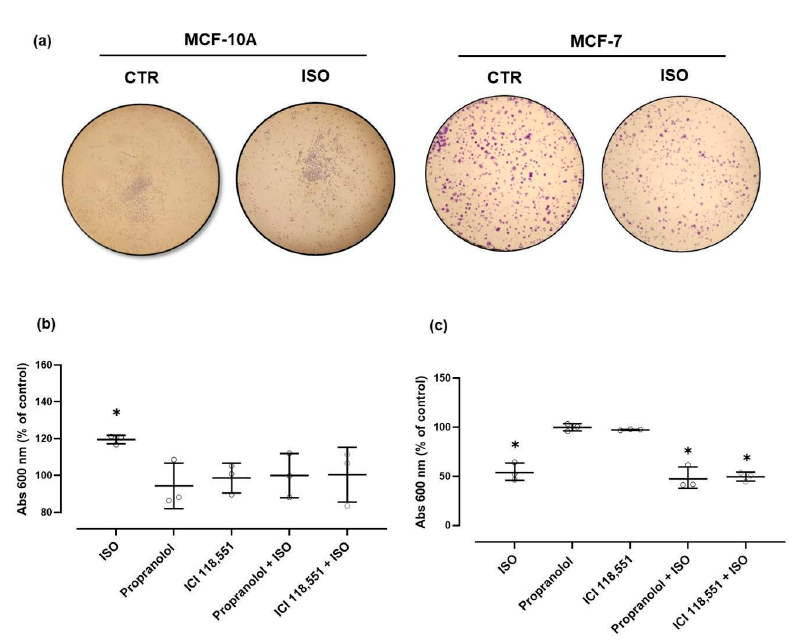
Figure 4. Influence of β -adrenoceptor agonist, 10 µM isoprenaline (ISO), alone or in combination with β -adrenoceptor antagonists, propranolol or ICI 118,551 (1 µM), in MCF-10A and in MCF-7 cells clonogenic ability. Cells were treated with the indicated drugs for seven days. ( a ) Representative images of the colony formation assay in MCF-10A and in MCF-7 cells in the absence or in the presence of isoprenaline (10 µM). ( b ) Results for absorbance ( λ = 600 nm: Abs 600 nm), after crystal violet elution in MCF-10A cells. ( c ) Results for absorbance ( λ = 600 nm: Abs 600 nm), after crystal violet elution in MCF-7 cells. Results are expressed as a percentage of control (solvent) and are presented as mean ± SD, from 3 independent experiments. Significant differences from control group: * p ≤ 0.05; one-way analysis of variance (ANOVA), followed by post-hoc multi-comparisons Dunnett’s test. In MCF-7 cells, this long exposure (7 days) revealed an ability of isoprenaline to reduce colony formation: isoprenaline (10 µM) reduced the number of colonies formed (Figure 4c) whereas propranolol or ICI 118,551 (1 µM), per se, did not change the clonogenic ability of MCF-7 cells. When combined with isoprenaline (10 µM), neither propranolol nor ICI 118,551 were able to antagonise the